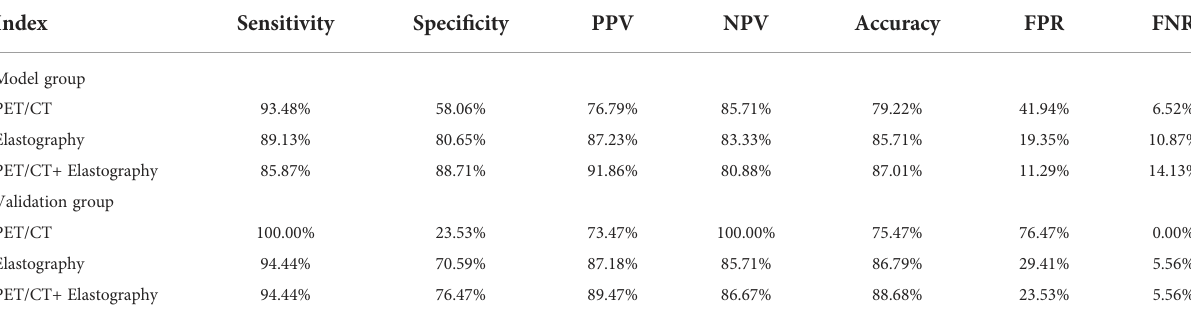
TABLE 5 The diagnostic ef fi ciency of PET/CT, elastography, and combination model in the model and validation groups.